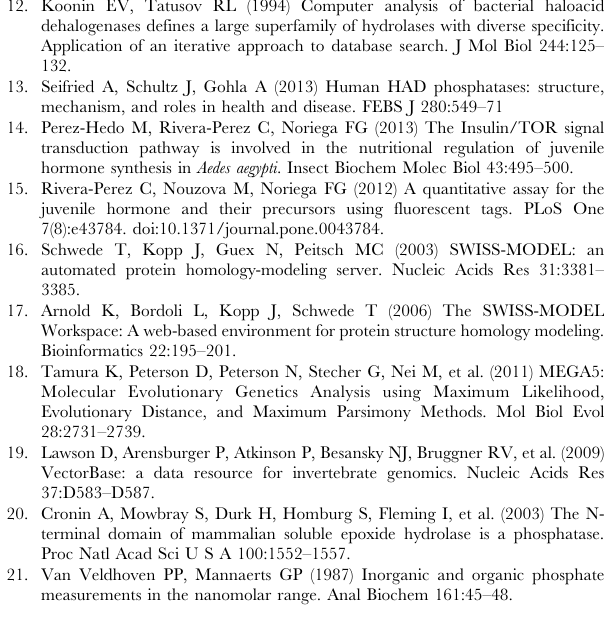
Figure S1 PCR analysis of the expression of eight putative phosphatase genes in the CA of adult female Aedes aegypti . (PDF) Figure S2 Chromatogram of a reverse-phase high performance liquid (HPLC) analysis showing the pro- duction of farnesol from FPP by Aa FPPase-1. (PDF) Figure S3 Effect of the inhibitor AGGC on Aa FPPase activity. (PDF) Figure S4 Schematic representation of the catalytic mechanism for Aa FPPases. (PDF) Table S1 Primers used for RT-PCR, Q-RT-PCR, and production of dsRNA .